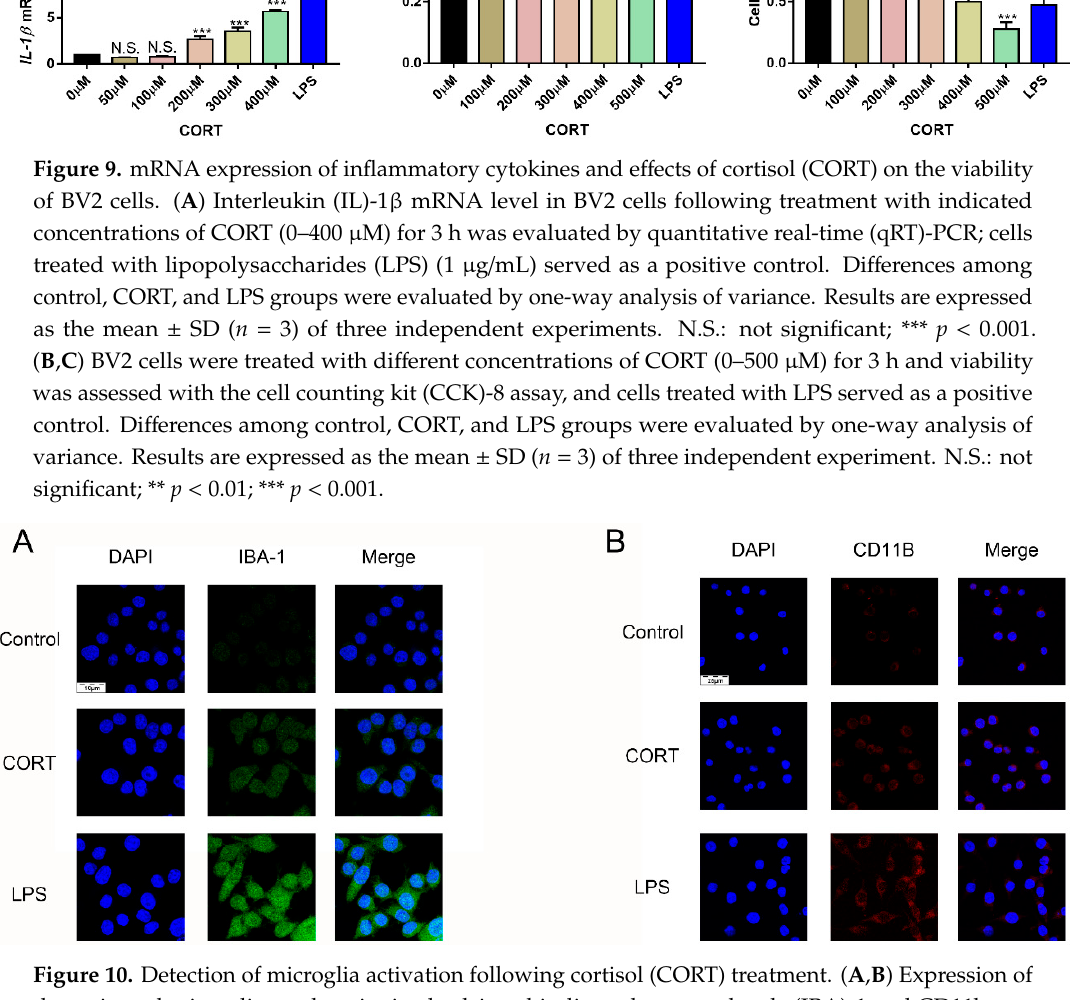
Figure 10. Detection of microglia activation following cortisol (CORT) treatment. ( A , B ) Expression of the activated microglia markers ionized calcium-binding adapter molecule (IBA)-1 and CD11b was detected by immunocytochemistry in cells with or without CORT treatment (200 µ M) for 3 h. Cells treated with LPS (1 µ g / mL) served as a positive control.